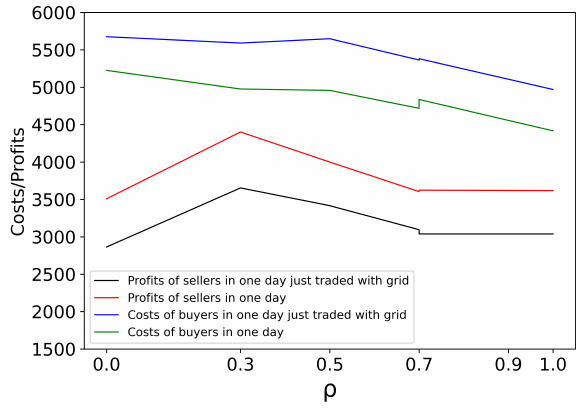
Figure 5. Evolution of loss and reward in training process.